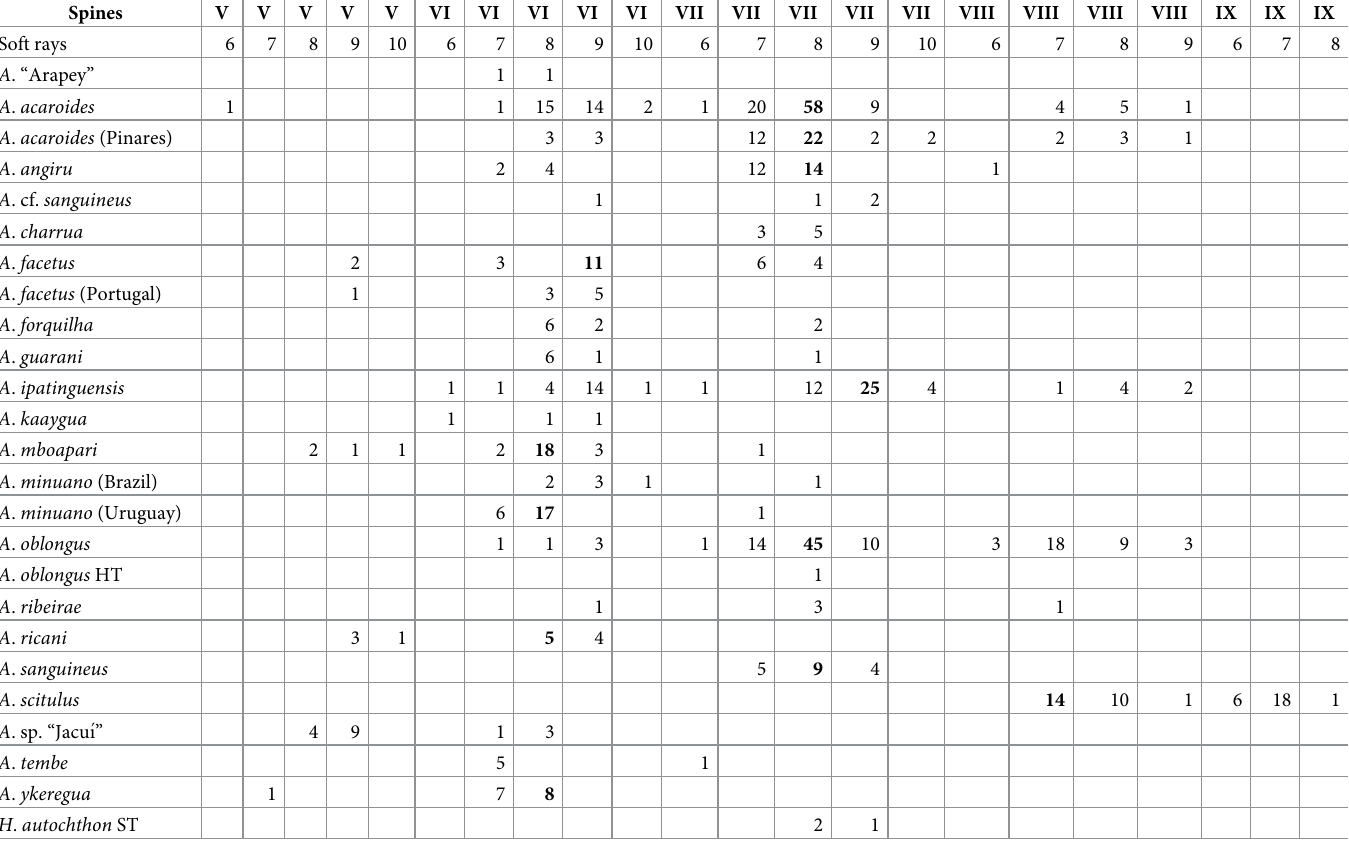
Table 7. Number of anal-fin rays in species of Australoheros .